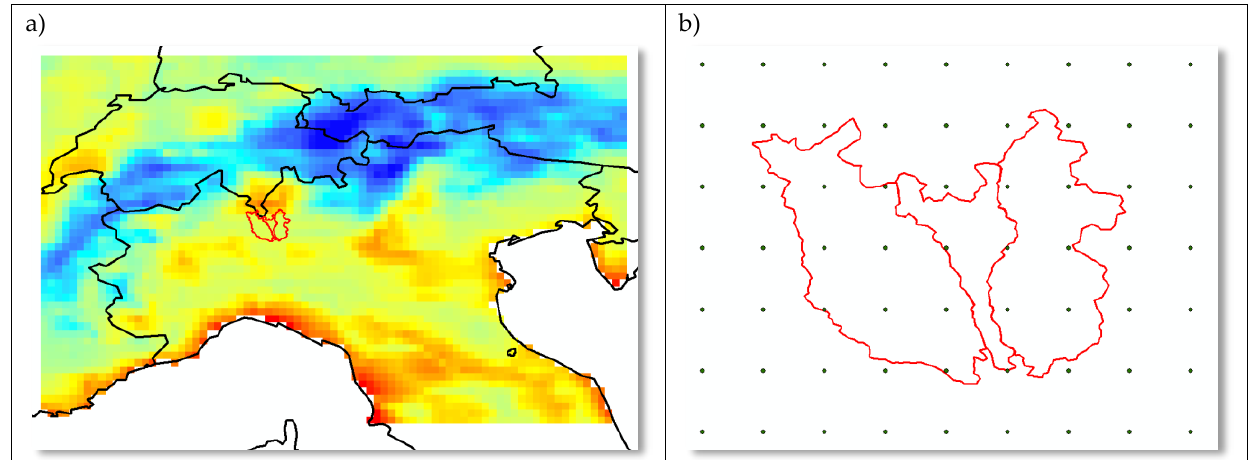
Figure 3. Example of ERA5 land temperature chart ( a ) and horizontal spatial resolution ( b ) over the SOL watersheds.